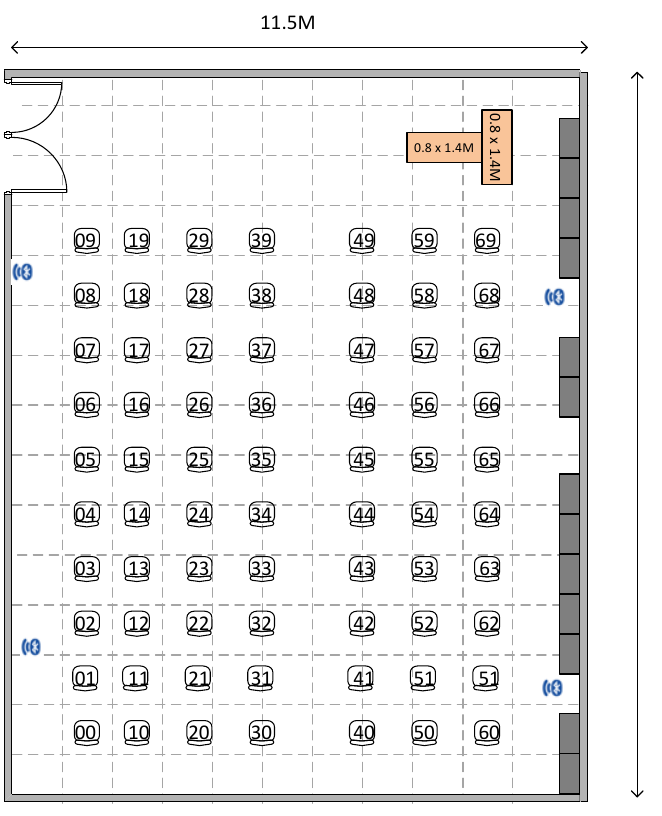
Figure 3. Test site for BLE indoor positioning (Classroom type III) .